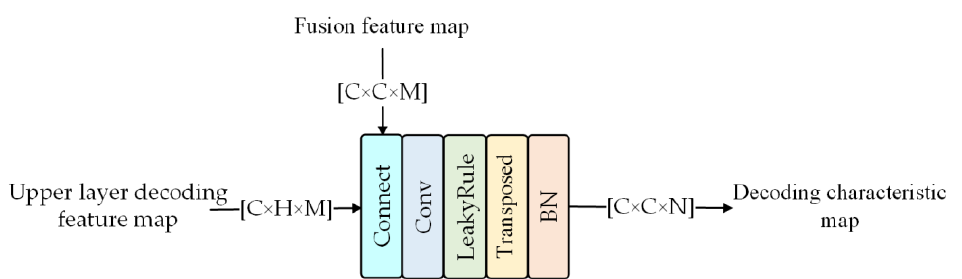
Figure 5. Structure of SEBlock module.